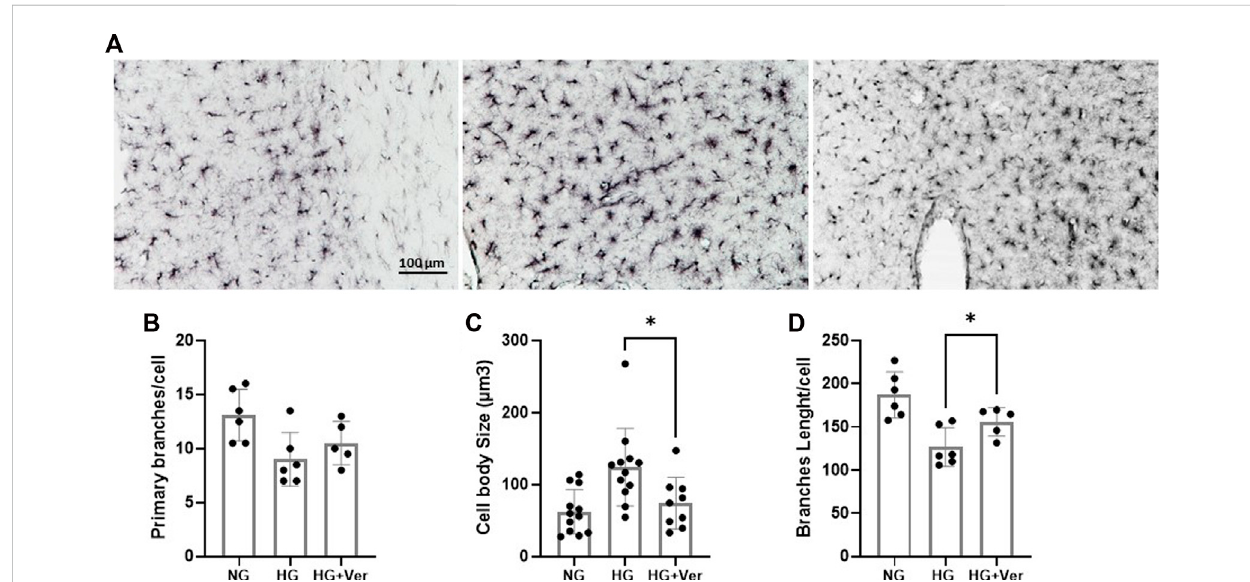
FIGURE 5 Intra-arterial verapamil mitigates microglial in fl ammatory transition following thrombectomy in a preclinical model of hyperglycemic stroke. Adult miceweresubjectedto 4 hintraluminalMCAO.Hyperglycemiawasestablished withintravenousglucose infusion (25%,40 µL/h)starting fromocclusion time till 1 h post- fi lament withdrawal. Glucose infusion was continued for one more hour at reperfusion, along with intra-arterial (i.a.) verapamil infusion (0.5 mg/kg, 40 µL/h, 1 h). As demonstrated in the representative images (A) , The number of primary branches following stroke did not change with prolonged hyperglycemia (5 h) or i.a. verapamil infusion (1 h) (B) . Prolonged hyperglycemia encouraged pro-in fl ammatory phenotype in penumbral microglia, as indicated by microglial hypertrophy (C) and reduced total branches length/cell (D) . The corresponding transitions to in fl